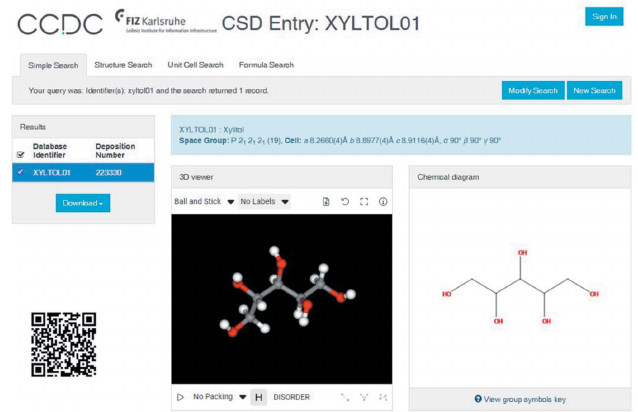
Figure 7 WebCSD graphical web interface illustrating the interactive visualization of one of the crystal structures of xylitol (refcode XYLTOL01). The QR code enables quick